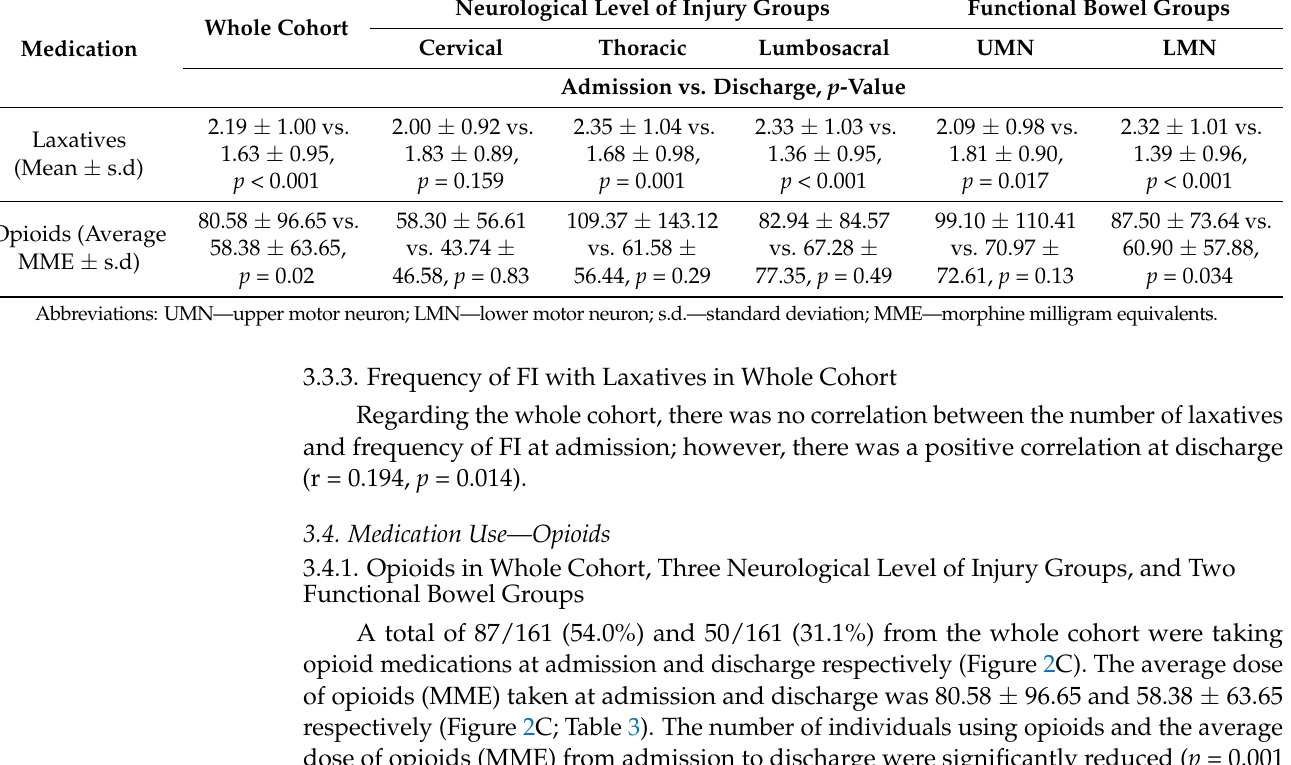
Table 3. Change in laxative and opioids use from admission to discharge in individuals with SCI during acute rehabilitation. Neurological Level of Injury Groups Functional Bowel Groups Whole Cohort Cervical Thoracic Lumbosacral UMN LMN Medication Admission vs. Discharge, p -Value Laxatives (Mean ±